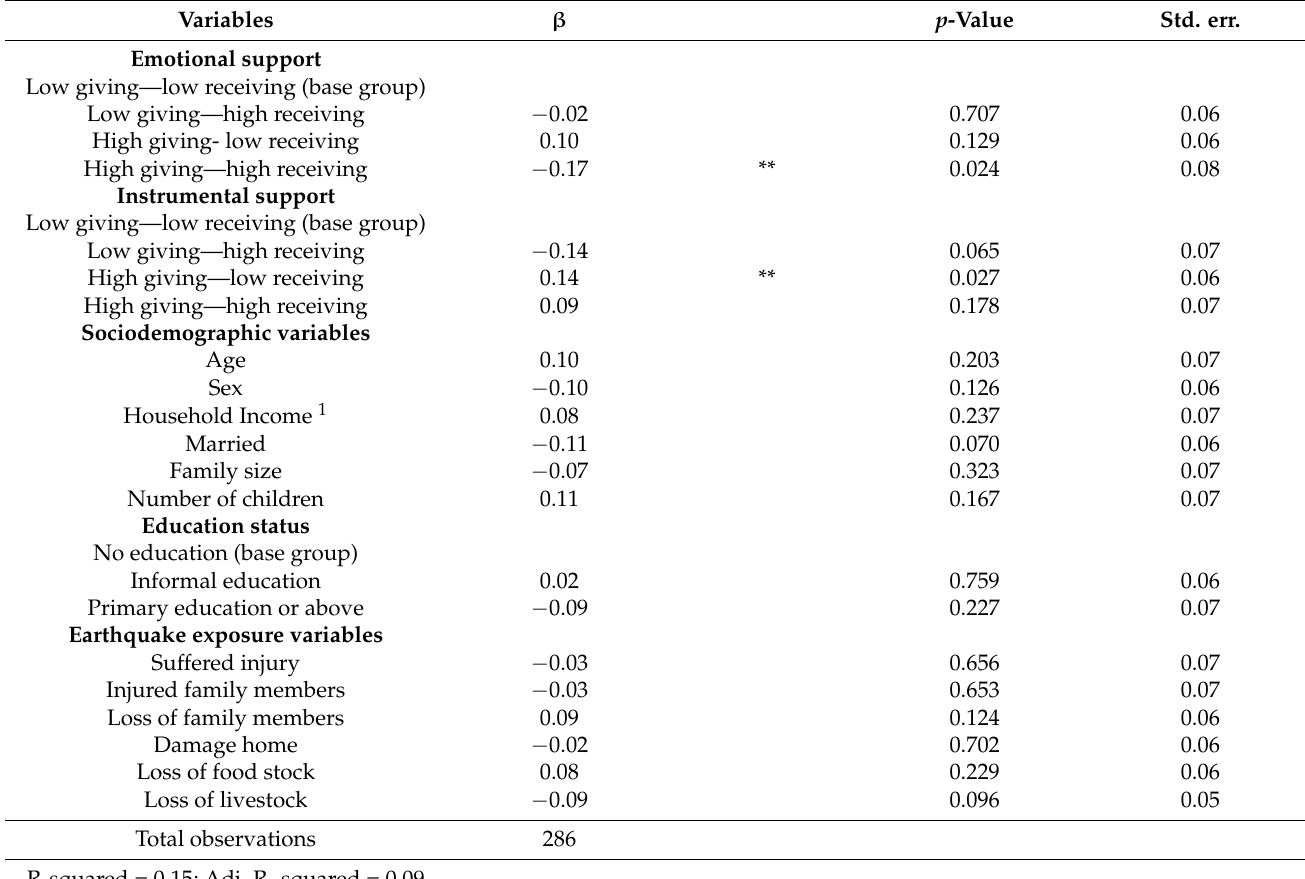
Table 5. Interaction effects of social support on depression